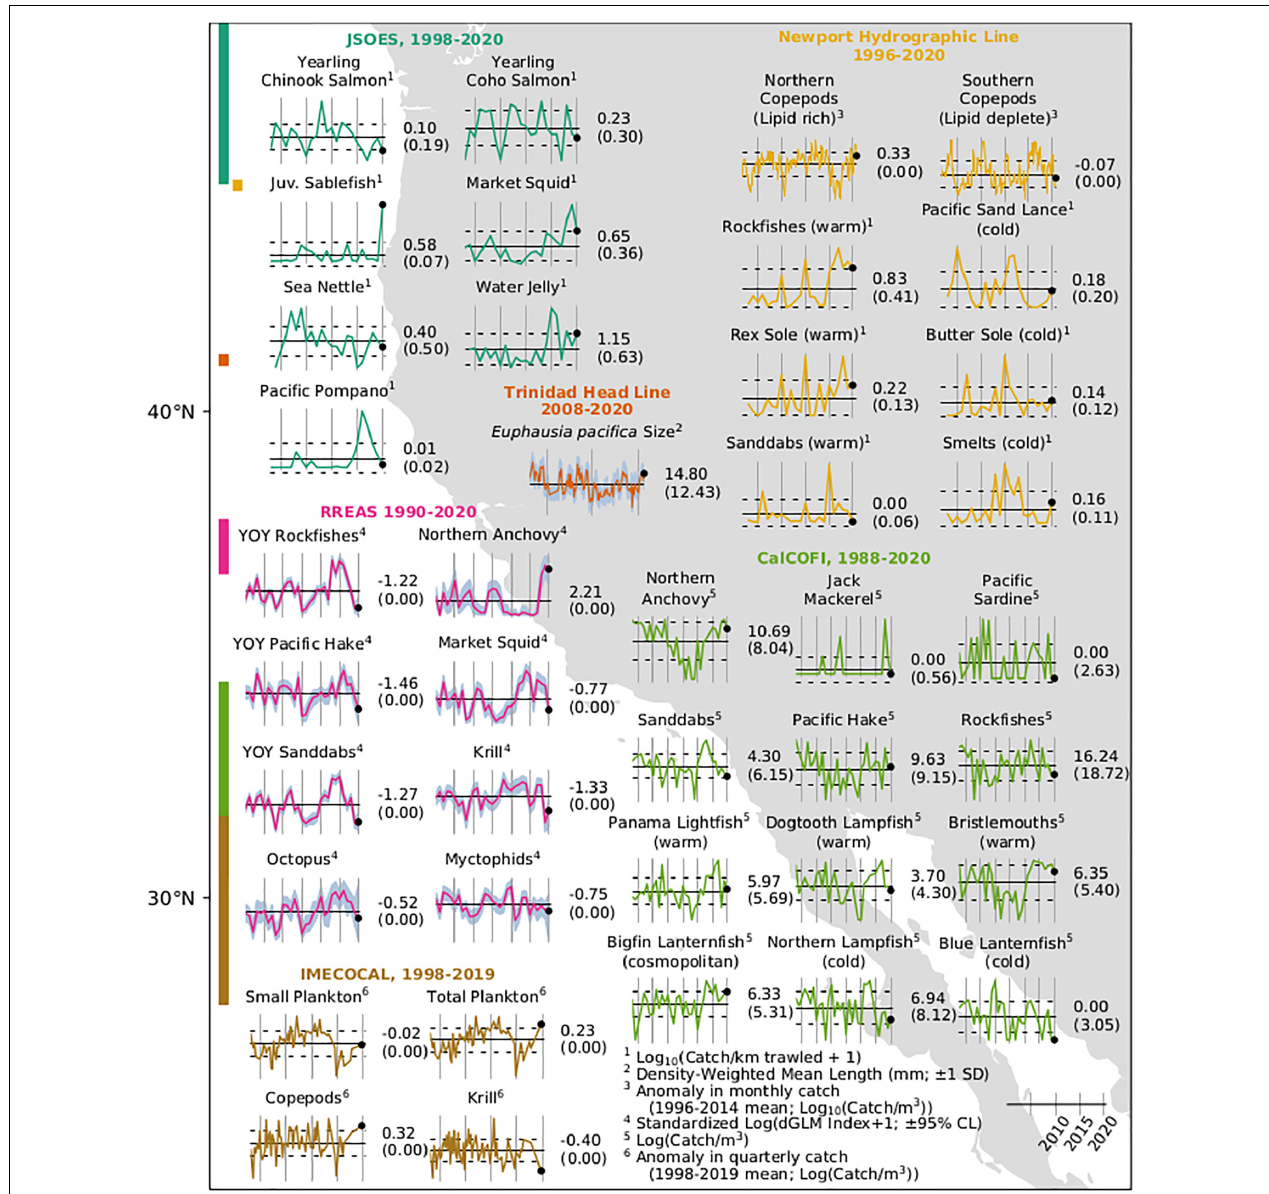
FIGURE 9 | Time series of abundances of fishes, zooplankton, and other invertebrates as measured by biological surveys in the CCS. Bars at left indicate the latitudinal sampling range of the surveys with colors corresponding to graphed data. Numbers to the right of each series indicate the value of the final measurement (black dot) and long-term mean (horizontal bar) in parentheses. Vertical bars are at 5-year intervals with the right-most bar at January 1, 2020. Dotted lines indicate ± 1 SE or blue shading indicates confidence limits as